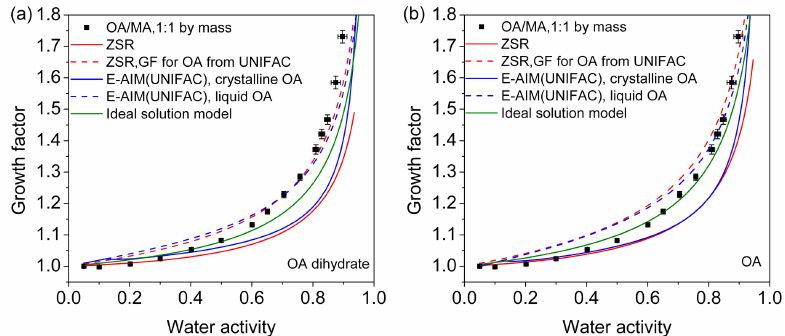
Figure 6. Hygroscopic growth factors of aerosols containing oxalic acid and malonic acid (OA / MA) at a mass ratio of 1:1 as a function of water activity. Initial particle diameter is about 100nm. Predictions from the ZSR, E-AIM (UNIFAC), and ideal solution model are also included, assuming (a) oxalic acid dihydrate and (b) anhydrous oxalic acid in the initial particles under dry conditions. The dashed lines are calculated based on liquid oxalic acid (OA) assumption. The uncertainty in our measured growth factors is within 0.02.